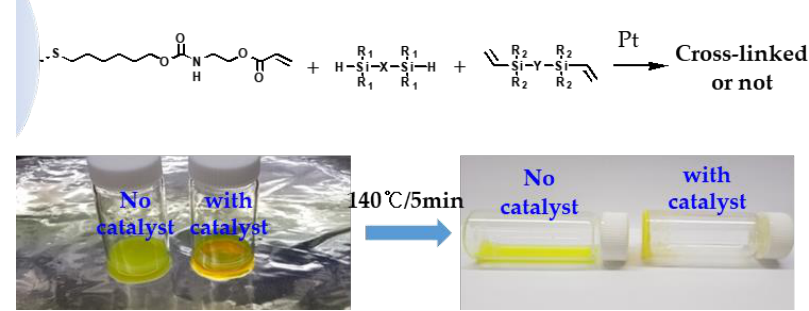
Figure 4. Results of the feasibility test to verify whether the functionalised QDs were reactive toward the siloxane